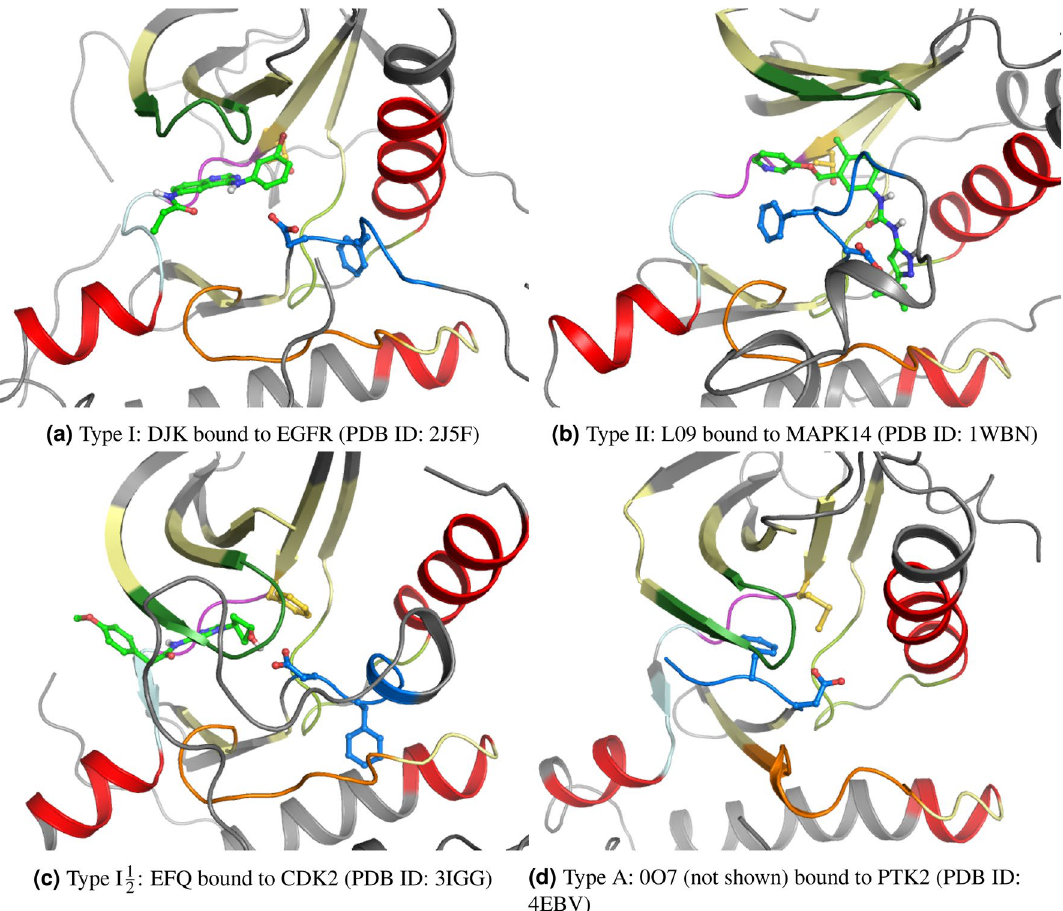
Figure 1. Snapshots, obtained from KLIFS 10–13 , for the binding site (with inhibitor) in each of the four binding modes (DFG: blue, α C-helix: red (upper right), inhibitor: light green). ( a ) Type I: DJK bound to EGFR (PDB ID: 2J5F 14 ), ( b ) Type II: L09 bound to MAPK14 (PDB ID: 1WBN 15 ), ( c ) Type I 3IGG 16 ), and ( d ) Type A: 0O7 (not shown) bound to PTK2 (PDB ID: 4EBV 17